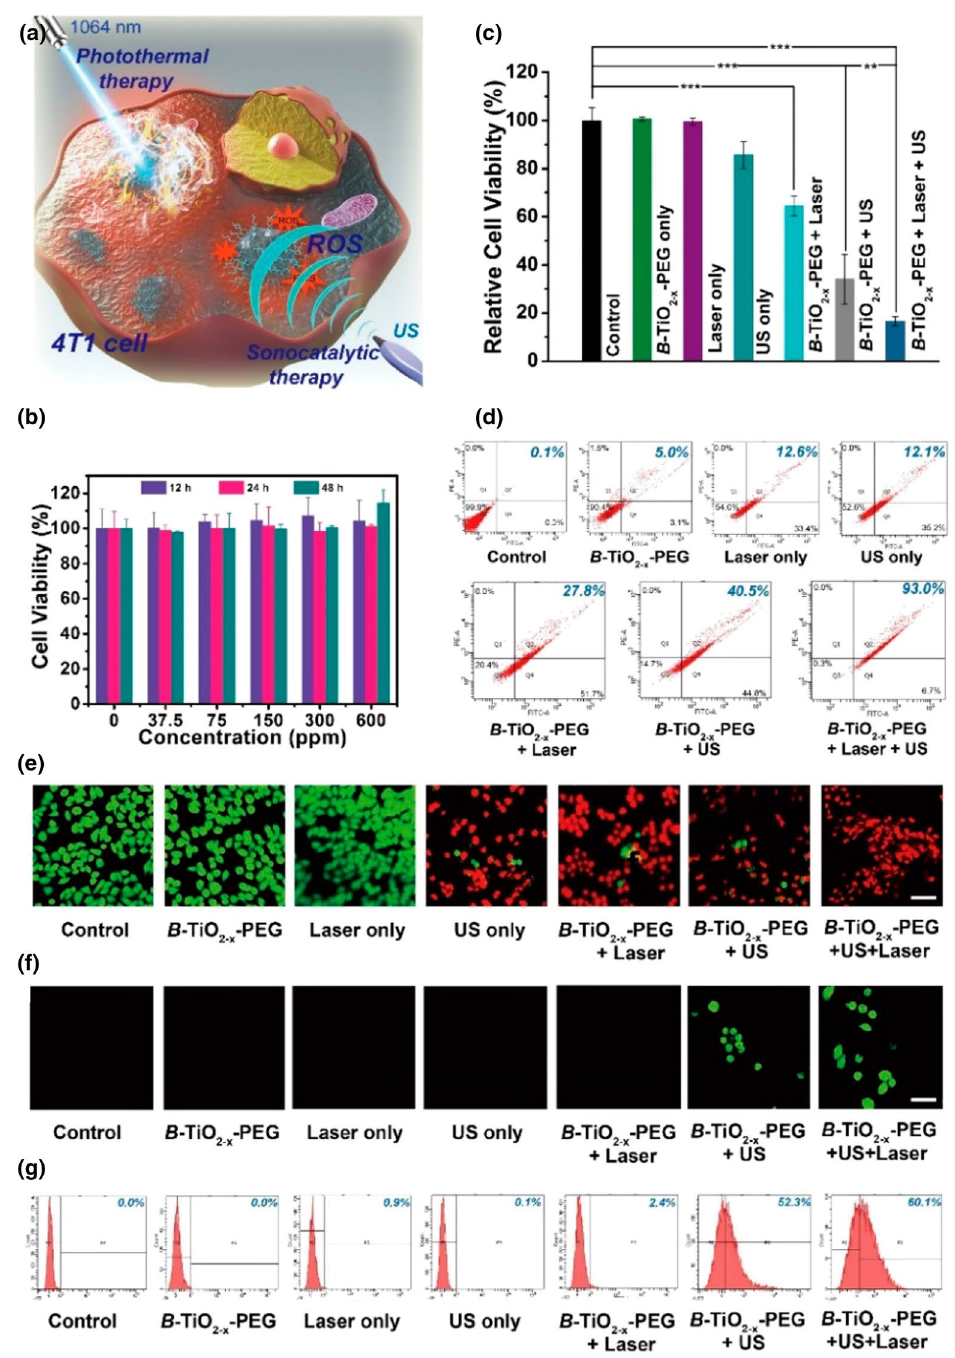
Fig. 13 Combined effect of NPs with light and US. a Scheme illustrating the synergy proposed. b Cell viability after incubation with the pro- posed nanosystem (B-TiO 2− x -PEG). c Cell viability after different treatments. *** p < 0.001. d Flow cytometry apoptosis assay after different treatments, staining with Annexin-FITC and PI. e Confocal laser scanning microscopy images of after different treatments, PI (red fluorescence), calcein-AM (green fluorescence). Scale bar 40 μm. f Confocal laser scanning microscopy images of cells stained with 2 ′ –7 ′ dichlorofluorescein diacetate after different treatments, scale bar 20 μm. g Flow cytometry measurement of ROS production. Adapted with permission from [154]. Copyright 2020 American Chemical